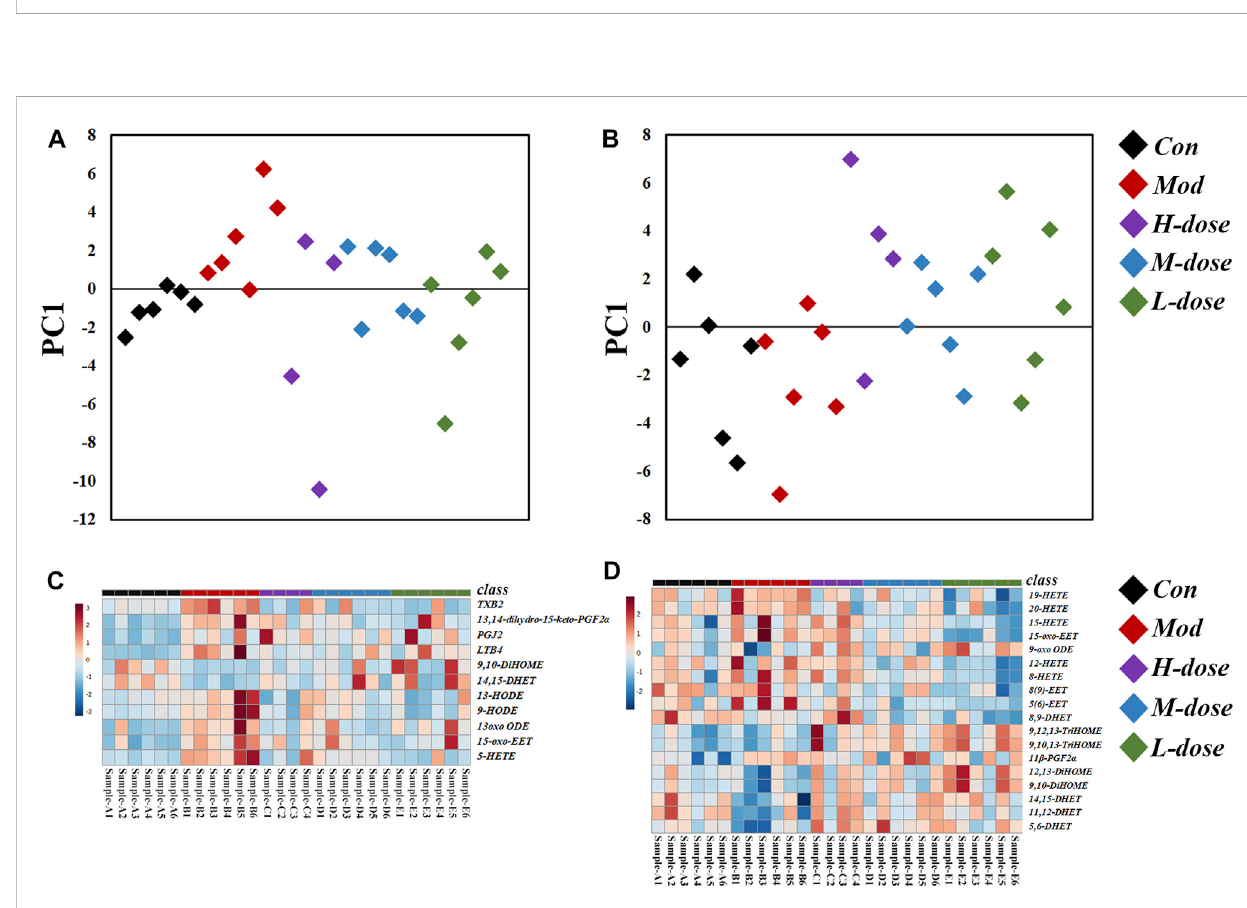
LMregulationofOVA-inducedasthmagroupandthecontrolgroup. (A) PCAscorescatterplotoflungtissue. (B) PCAscorescatterplotofserum. (C) Heatmap of lung tissue. (D) Heatmap of